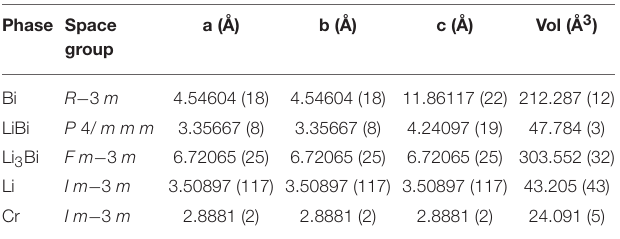
TABLE 1 | Space groups and refined lattice parameters of phases identified in the diffraction data shown in Figure 2B . Phase Space group